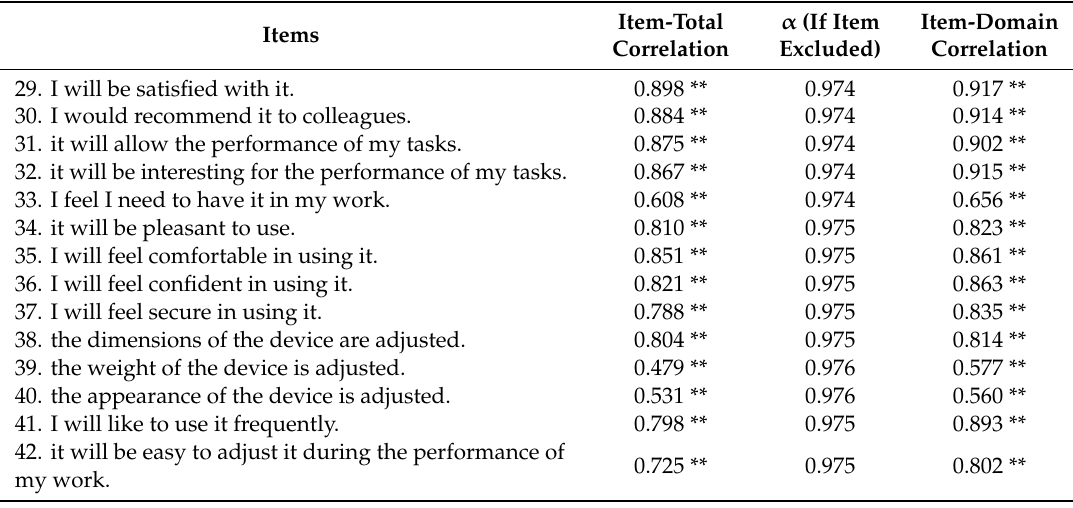
Table 5. Satisfaction / Intention to use items (Concerning the possibility of using the double-chamber syringe for intravenous therapeutics in the